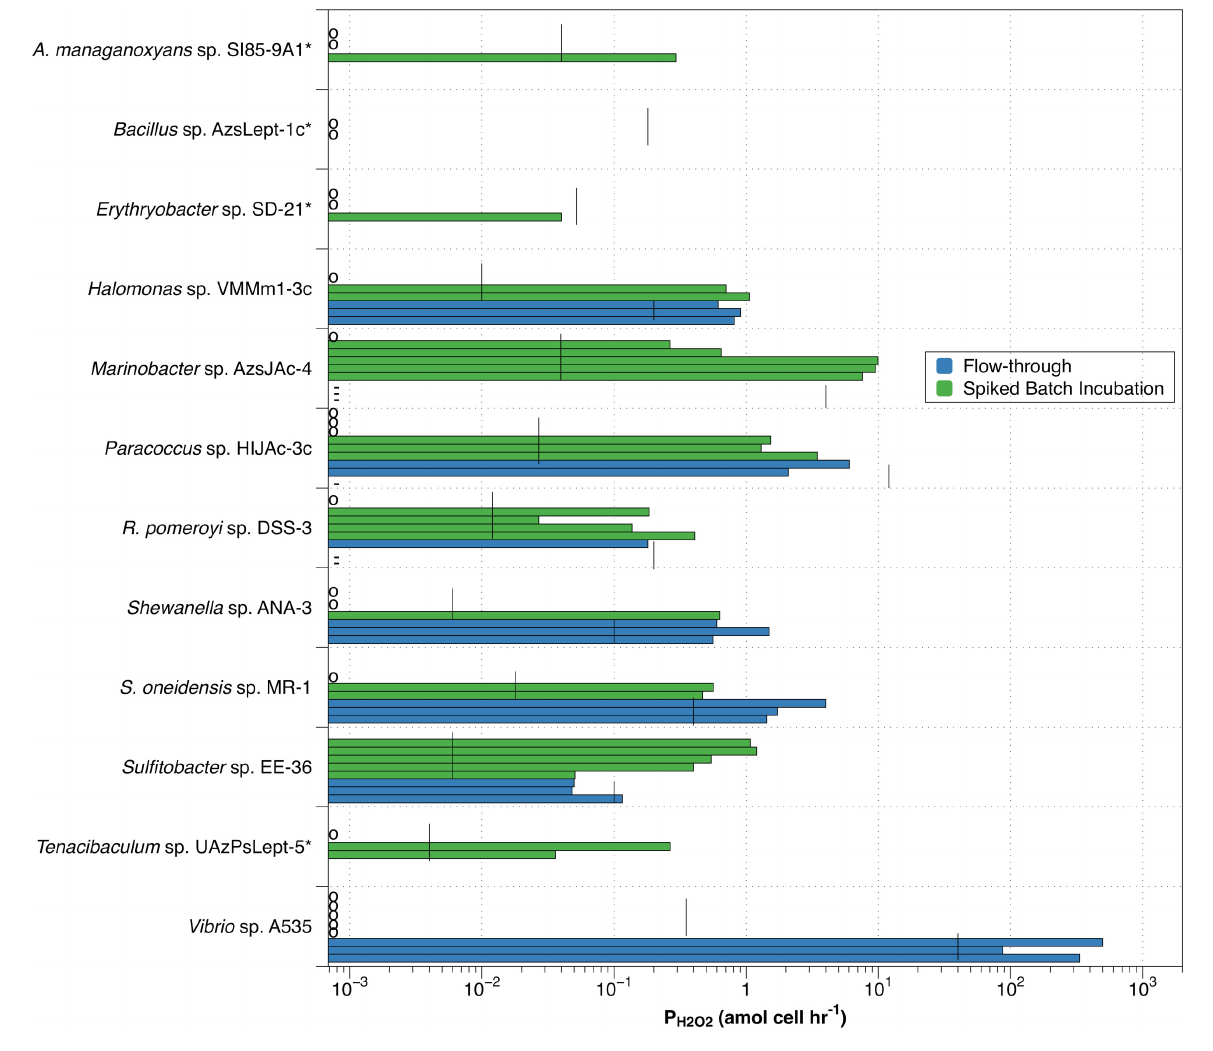
FIGURE 3 | Individual values for H 2 O 2 production rates by spiked batch incubation (green bars) and flow-through method (blue bars). Vertical black lines indicate detection limit (DL prod ) for both methods. Species marked by an asterisk( * ) were not evaluated by flow-through methodology. Small circles along y -axis indicate a measurement of zero; dashes (-) along y -axis indicate observed negative production in the flow-through